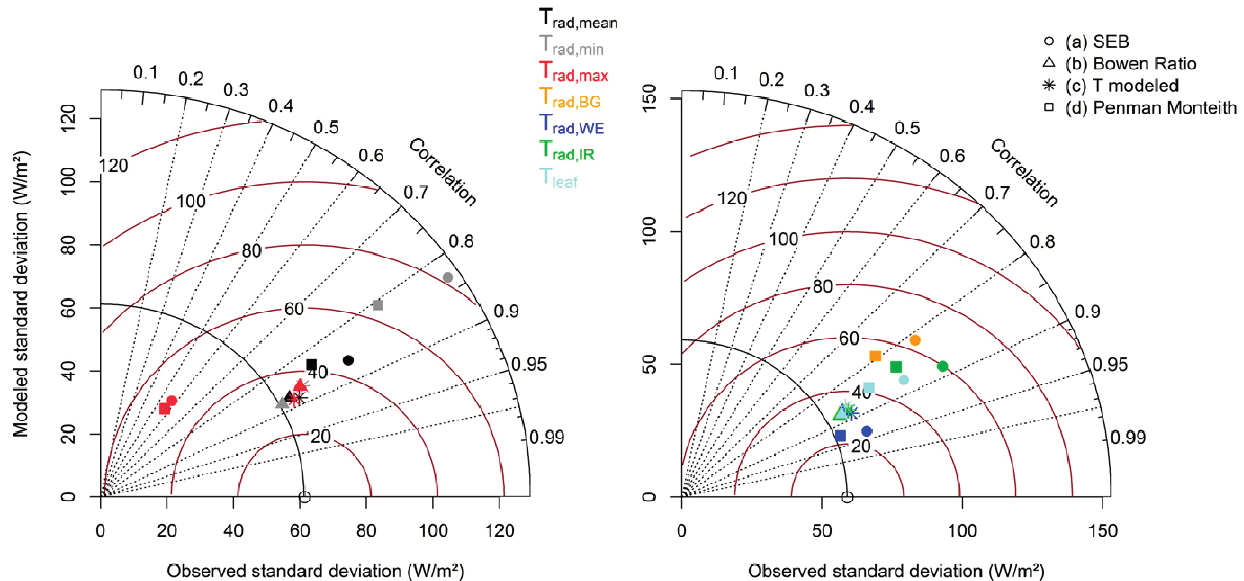
Figure 5. Taylor diagram displaying the statistical comparison of modeled daytime λ E (for model-specific symbols, see the figure legend) to the observed daytime latent heat flux derived from eddy covariance measurements (the open circle located on the X-axis). The diagram compares correlation values (dotted black lines), the root-mean-square difference (solid dark red lines) and the standard variation (distance from the origin) of modeled and measured λ E . Solid black line: standard deviation of measured λ E . Input surface temperatures ( T ) as for Table 2. For model abbreviations, cf. Table